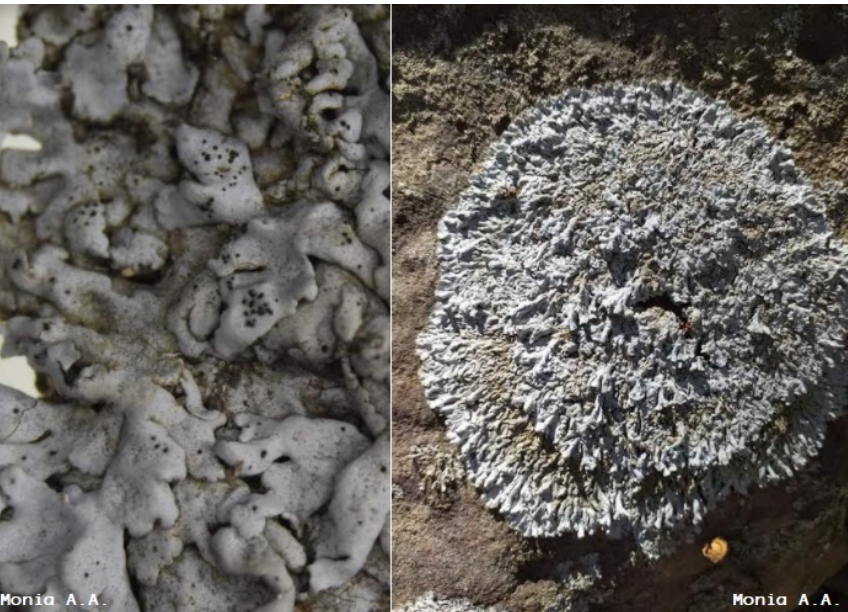
Figure 1. Algerian Physcia mediterranea Nimis photographed in the national park of El Kala, Algeria.